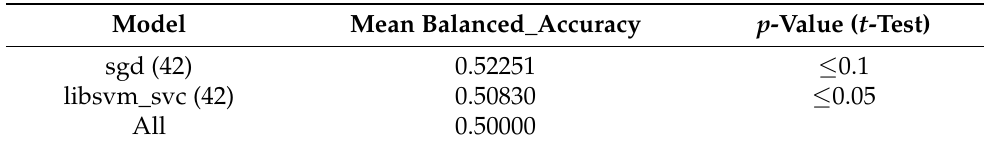
Table A1. Models with significantly better mean balanced accuracy.